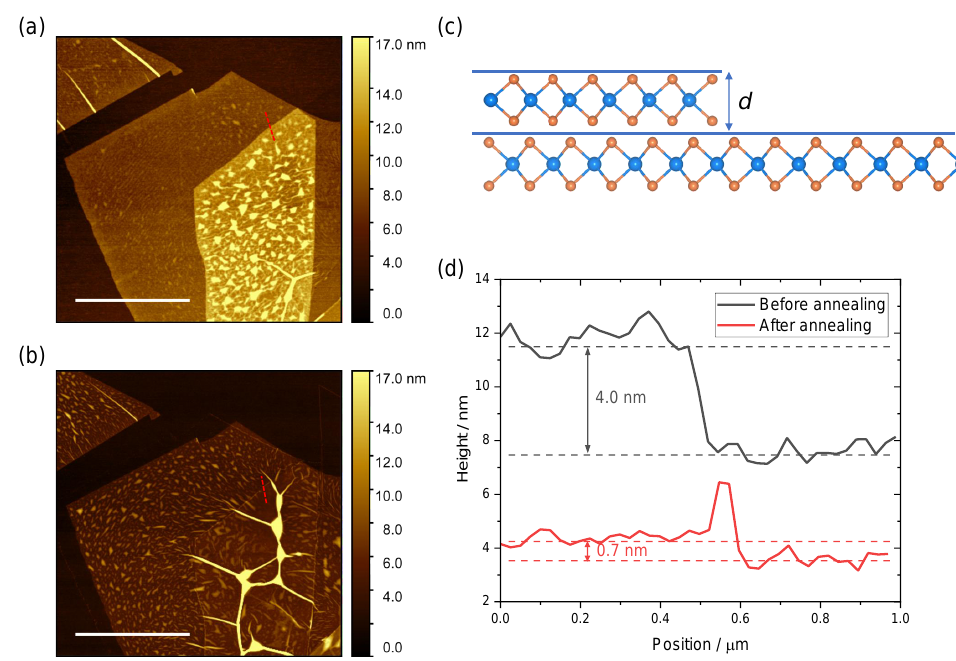
Figure 3. AFM of monolayer and bilayer WSe 2 ( a ) before and ( b ) after annealing. ( a , b ) share the same color scale. The measured area corresponds to the white squared area in Figure 2a. ( c ) Schematic diagram of the AFM profile. ( d ) Height profile of monolayer and bilayer WSe 2 before and after annealing. Scale bar in figure is 4